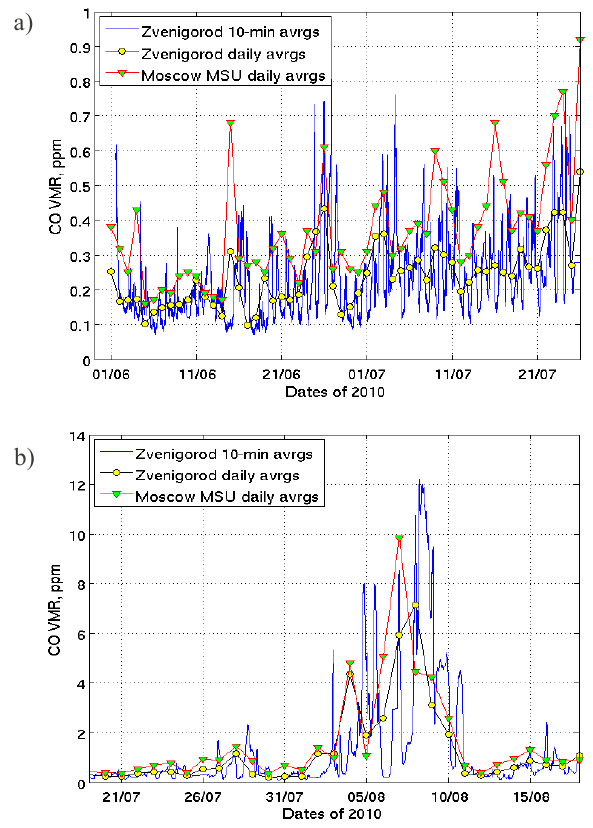
Fig. 7. CO VMR in the surface layer in Moscow and a rural site, Zvenigorod: (a) before, and (b) during the fire period. Note the different scales. Ticks correspond to 12:00 Moscow local time (UTC+4h).